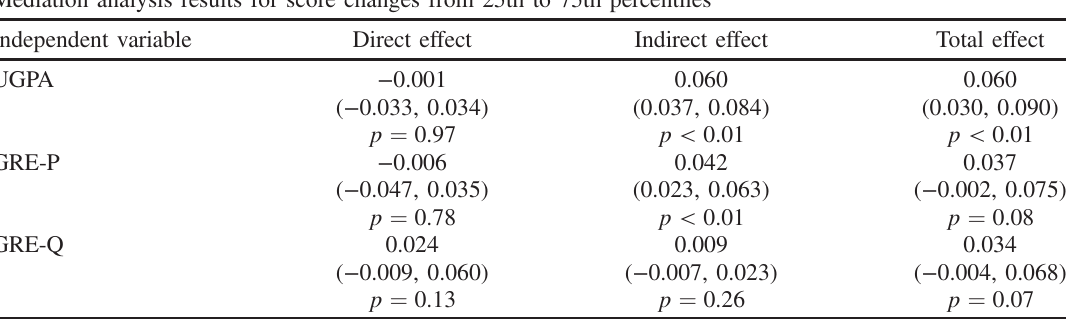
TABLE IV. Results of mediation analyses that show the predicted change in probability of Ph.D. completion due to changes in admissions metrics from their 25th percentile values to their 75th percentile values among students in the study. The predicted total effect of UGPA is to increase a student ’ s overall probability of Ph.D. completion by 6.0% ( p < 0 . 01 ). That effect is entirely attributable to the indirect effect of UGPA on completion through graduate GPA. The total effects associated with GRE-P and GRE-Q are not statistically significant. Mediation analysis results for score changes from 25th to 75th